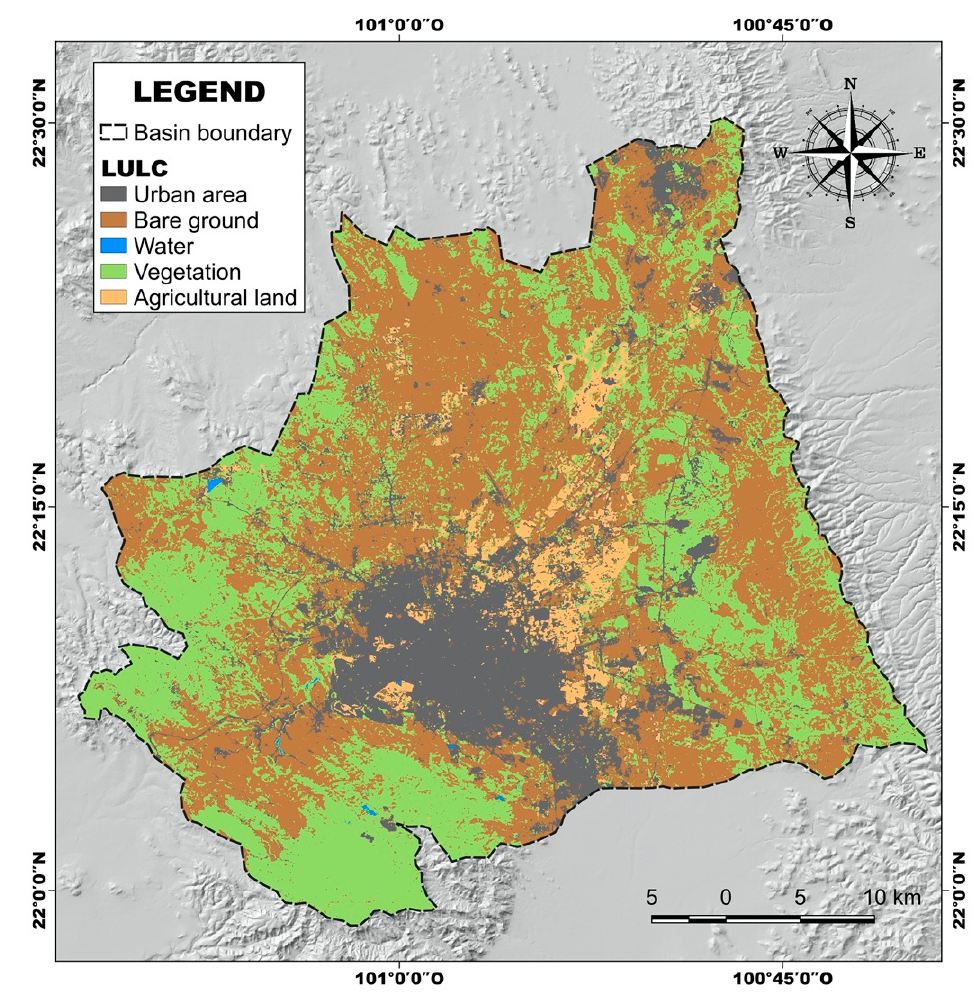
Figure 9. Land Use and Land Cover of the San Luis Potosi Basin.